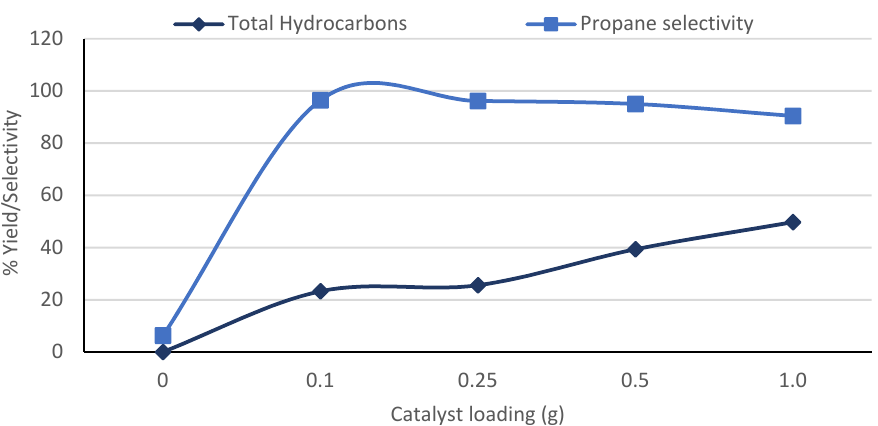
Figure 6. Effect of bulk Pt/C catalyst loading with 1.0 g butyric acid (1.14 M) at 300 °C after 1 h reaction time.